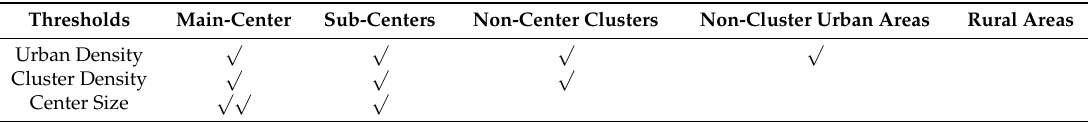
Table 1. The three thresholds to separate a metro into five submetro